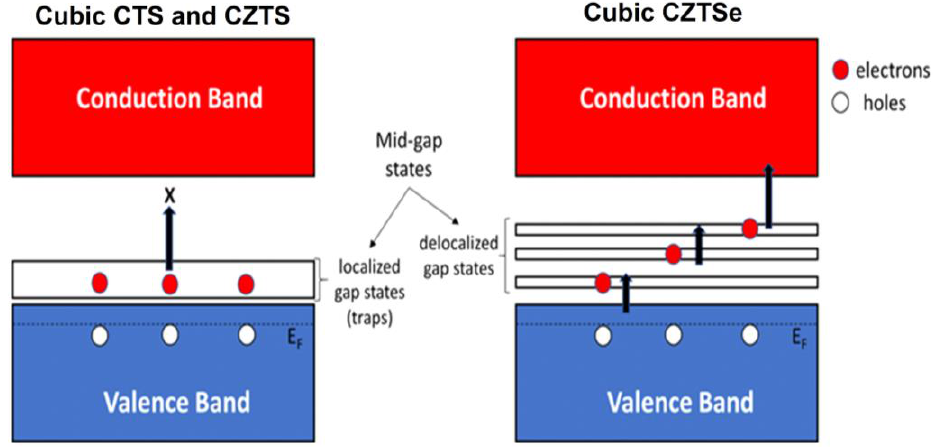
Figure 6. A schematic diagram showing the effect of mid-gap states: In cubic CTS/CZTS, the localized nature of these states acts to unilaterally enhance hole concentration at finite temperature by ‘trapping’ electrons. For cubic CZTSe instead, these states are delocalized within the gap, and therefore do not act as traps.